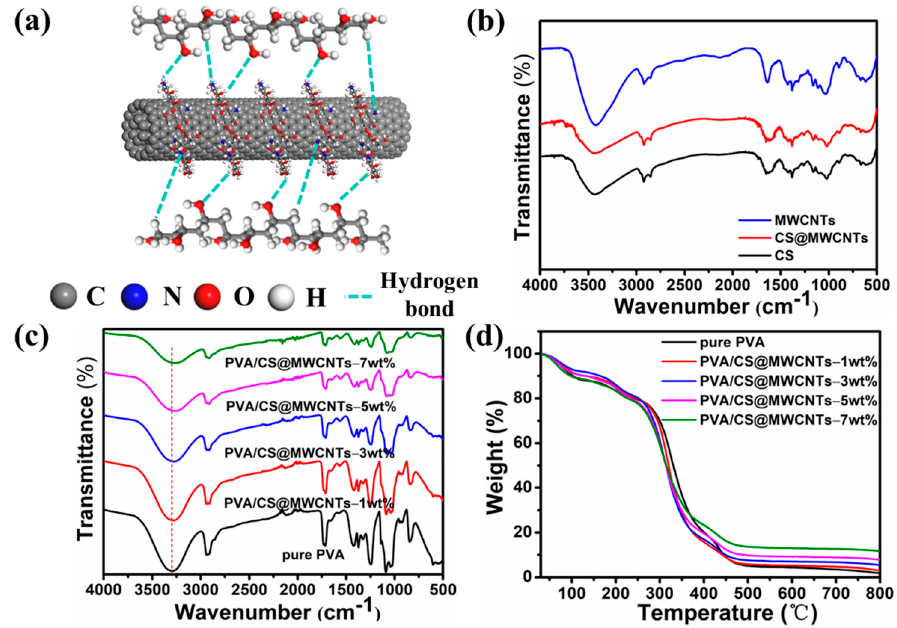
Figure 4. ( a ) Illustration of the interactions between PVA matrix and CS@MWCNTs by hydrogen bonds; ( b ) FTIR spectra of CS, MWCNTs and CS@MWCNTs; FTIR spectra ( c ) and TGA curves under nitrogen atmosphere ( d ) of pure PVA and PVA/CS@MWCNTs composite films containing 1 wt%, 3 wt%, 5 wt%, and 7 wt% MWCNTs.